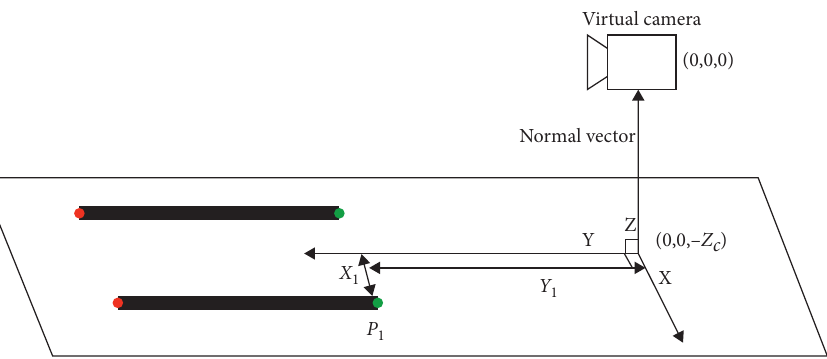
Figure 4: Relationship between lane endpoints and a virtual